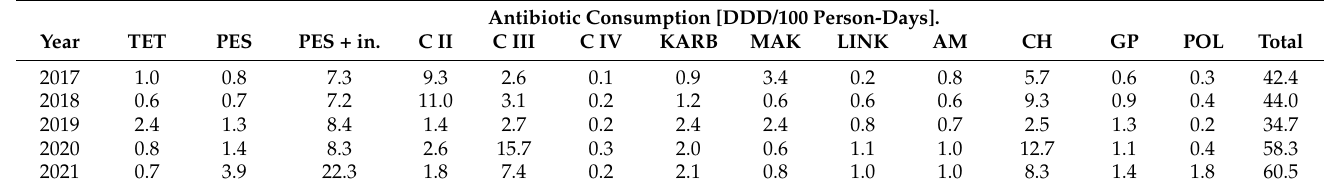
Table 5. Consumption of antibiotics and chemotherapeutics for general use in 2017–2021 at the multi-profile hospital in Wroclaw. Antibiotic Consumption [DDD/100 Person-Days].